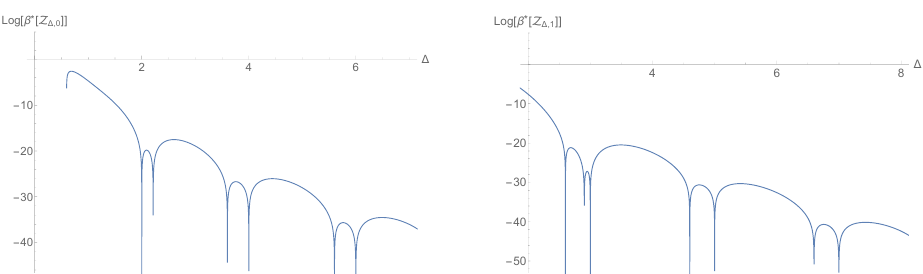
Figure 10. The extremal functional (cid:12) (cid:3) acting on spin-0 (left) and spin-1 (right) primaries at c = 38 and (cid:1) t = 8 . 5 5